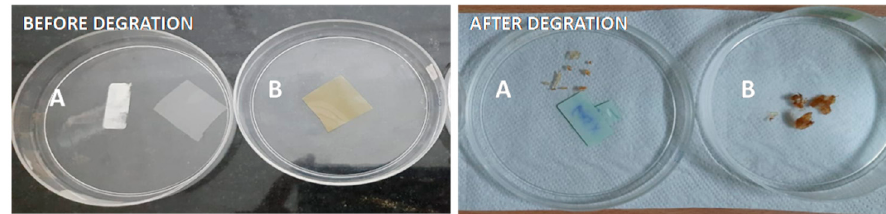
Figure 10. Biodegradation studies of films: ( A ) CG ( B ) CG4.